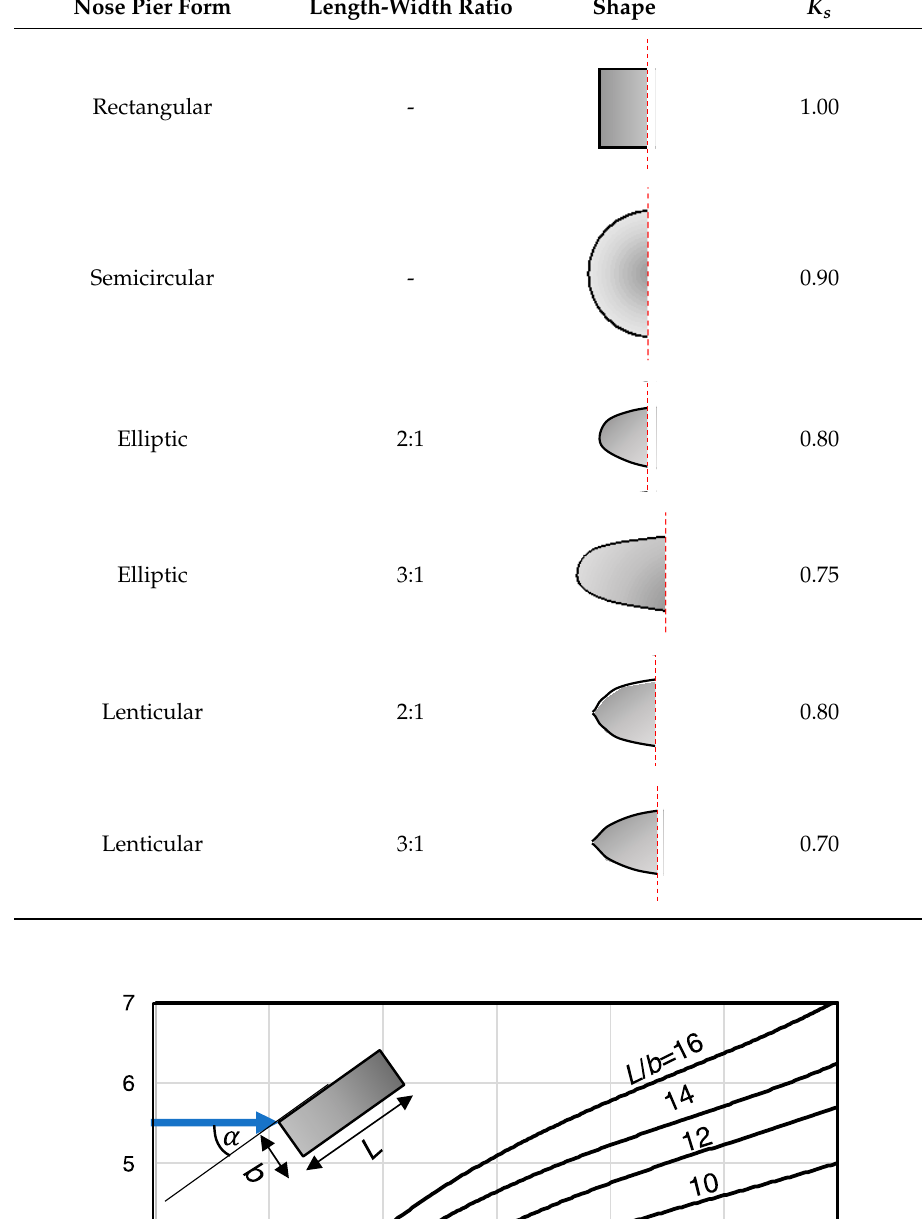
Table 6. Shape coefficients K s for various nose pier form [12].